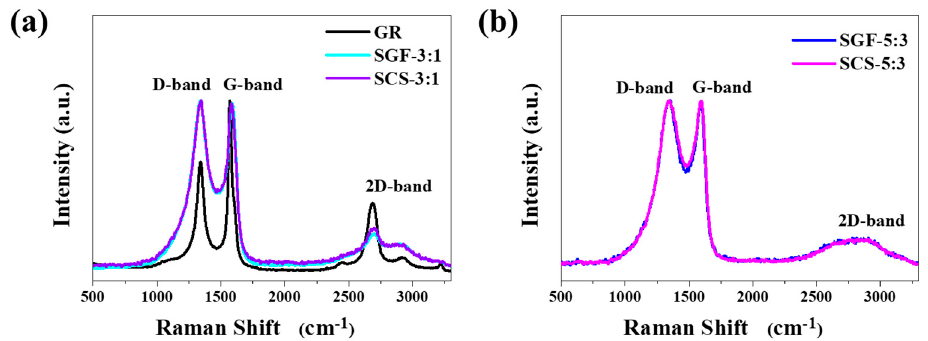
Figure 3. Raman spectra of ( a ) graphene, SGF-3:1 and SCS-3:1, ( b ) SGF-5:3 and SCS-5:3 sample. Table 2. Fitting results of the Raman spectra for graphene (GR), SGF-R, and SCS-R samples.